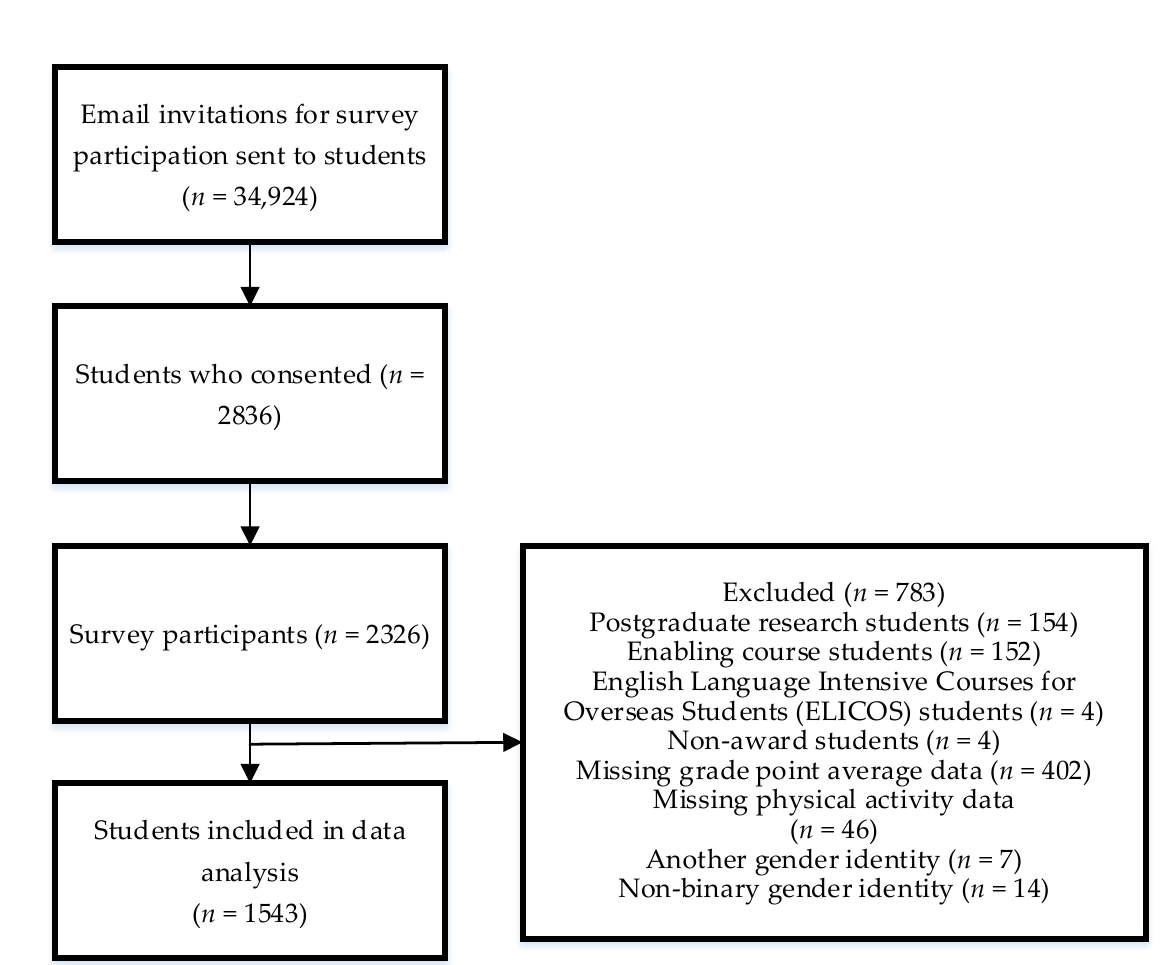
Figure 1. Participant exclusion flowchart for statistical analysis.